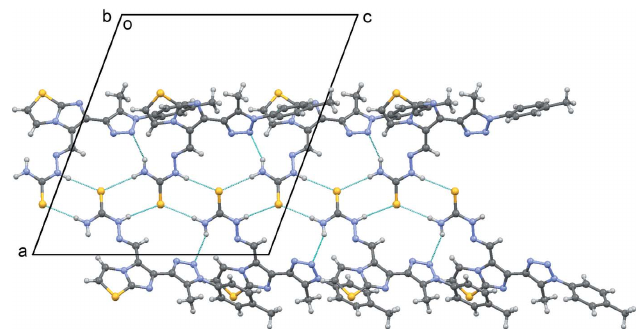
Figure 2 A view of a segment of the crystal structure viewed down the b axis. Intermolecular contacts are shown as blue dotted lines.